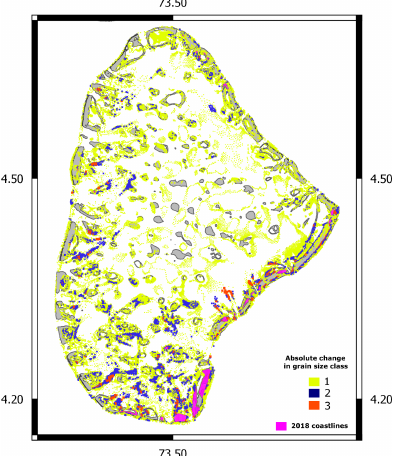
Figure 9. Absolute difference in bed sediment grain class arising from a sea level rise of 2m, with boundaries of lagoons from Spald- ing et al. (2001) in grey. Major changes in grain size class is pre- dicted to occur near the channels and the lagoonal faros.